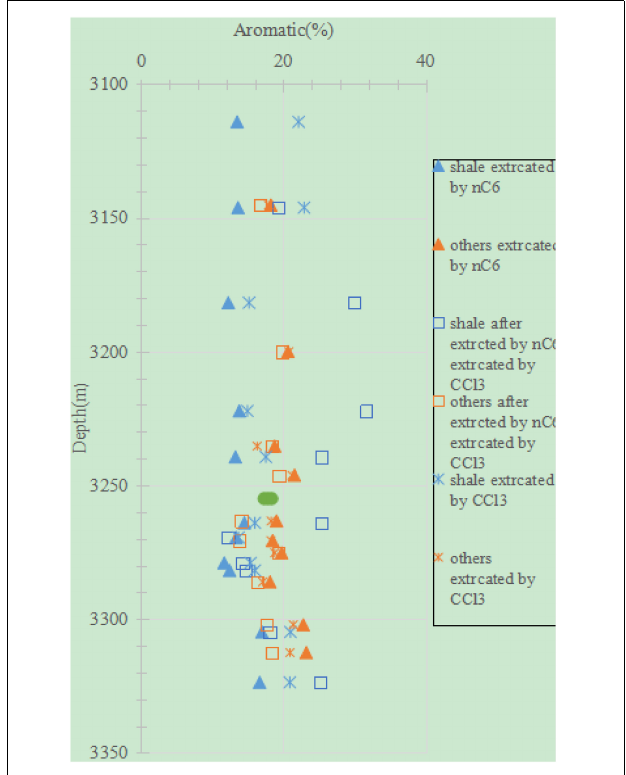
of which four (#3, #9, #15, and #22) were also subjected to high- pressure mercury injection analysis. The experimental results are presented in Appendix Tables A3 , A4 , respectively.